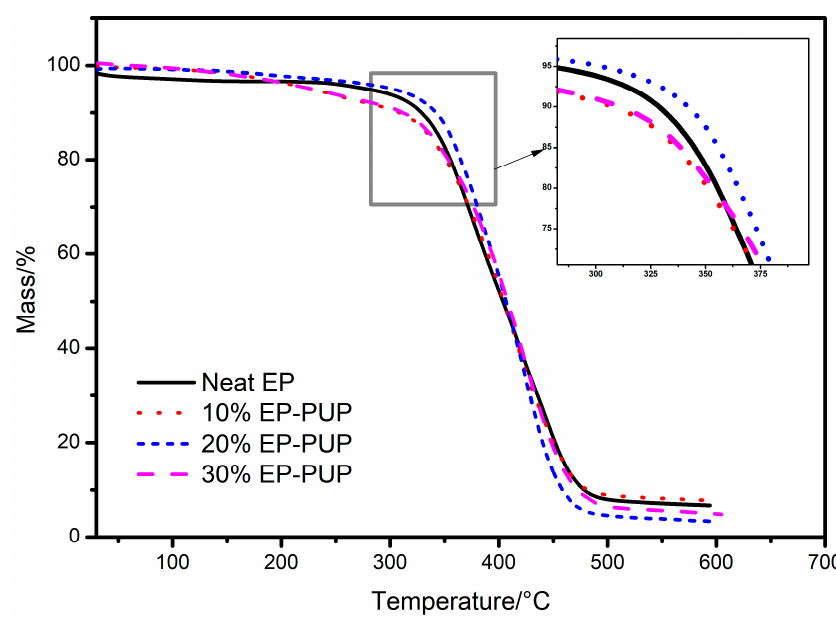
Figure 6. TG curves for the different cured samples. Table 2. Temperatures of different weight loss